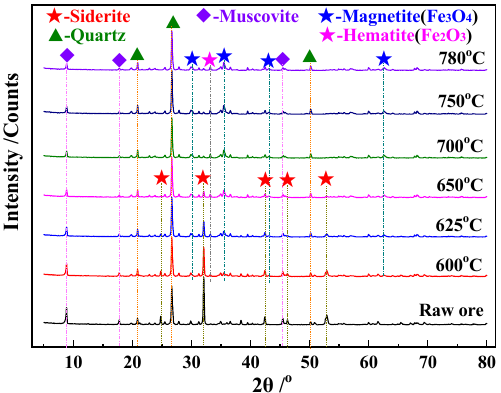
Figure 11. XRD patterns of the roasted ore recorded at different temperatures.